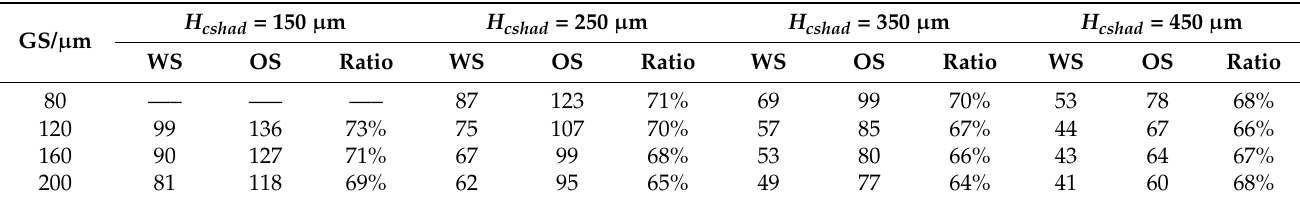
Table 1. Energy deposition (J · cm − 3 ) in deep vessels with different H cshad values and geometric shadows (GSs). H cshad = 150 µ m GS/ µ m